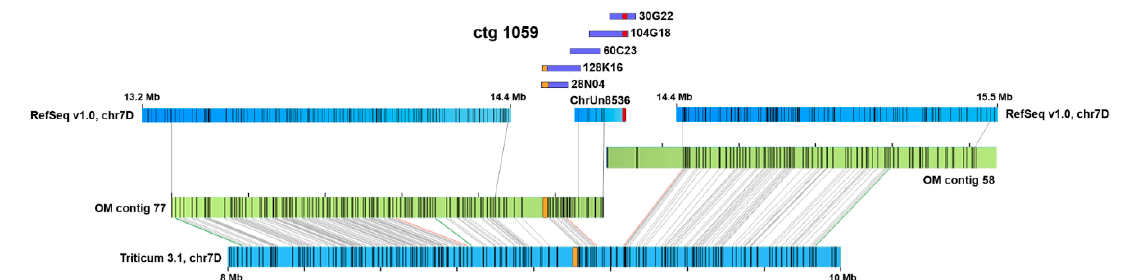
Figure 3. Organization of the TaeCsTr99 region. Positions of two TaeCsTr99 arrays (highlighted in orange and red) and an overall arrangement of the region were obtained by aligning ChrUn8536, IWGSC RefSeq v1.0 [3] and Triticum 3.1 [12] 7D pseudomolecules (blue bars) and BAC clones of 7DS physical-map contig 1059 [30] (violet bars) to 7DS optical map [26] (green bars). Numbers at the 7D pseudomolecules indicate assembly coordinates.